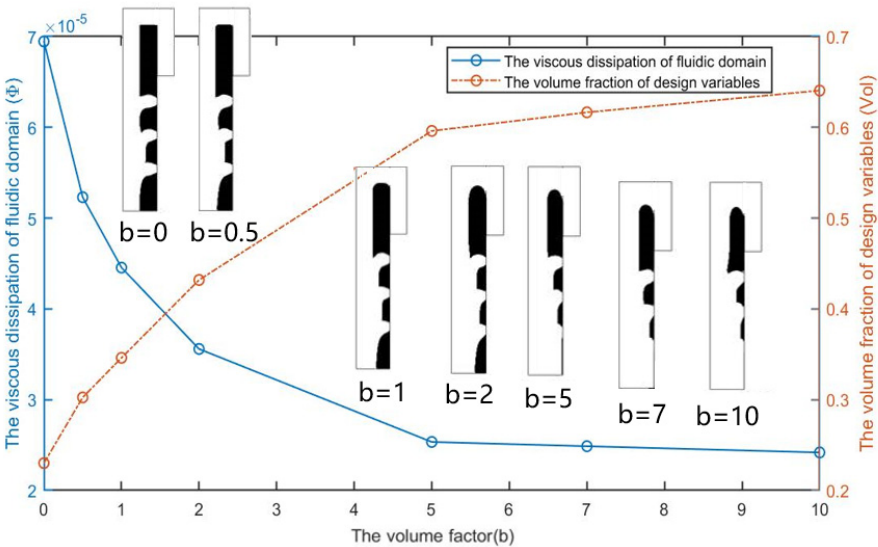
Figure 10. The optimization results and the effect of the volume coefficient 𝑏 on the volume fraction vol of design varia- bles and the viscous dissipation 𝛷 of fluidic domain. vol of design variables and the viscous dissipation Φ of fluidic